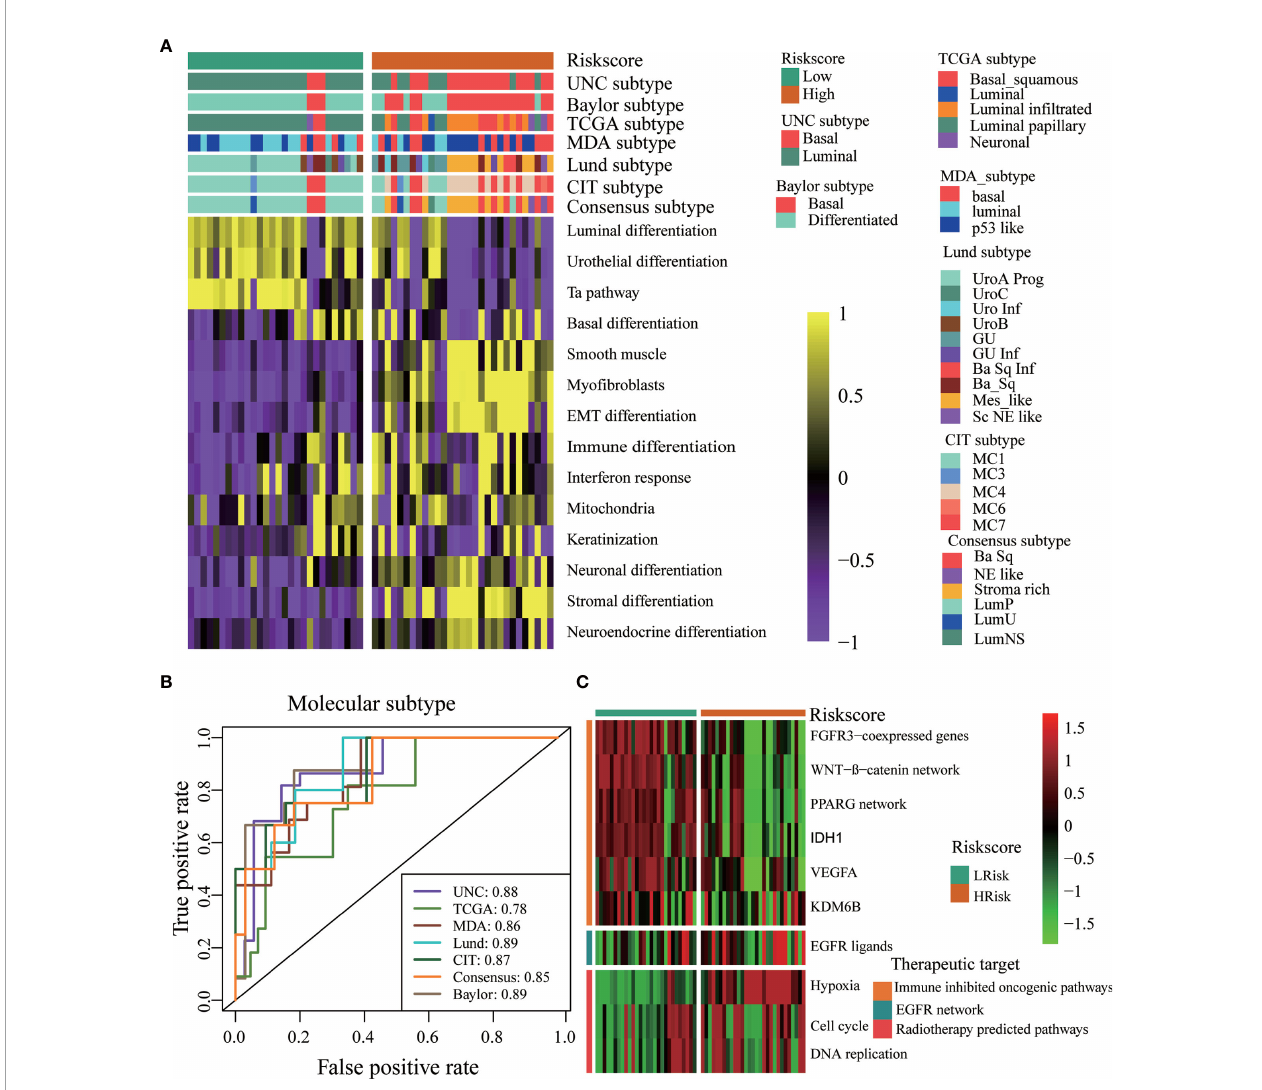
FIGURE 7 | The TGF- b risk score predicted molecular subtypes and treatments opportunities in the Xiangya Cohort. (A) The risk score accurately strati fi ed the molecular subtypes in different algorithms. (B) Accuracy of the risk score in predicting molecular subtypes in different algorithms. (C) Associations between the TGF- b risk score and the enrichment scores of several therapeutic